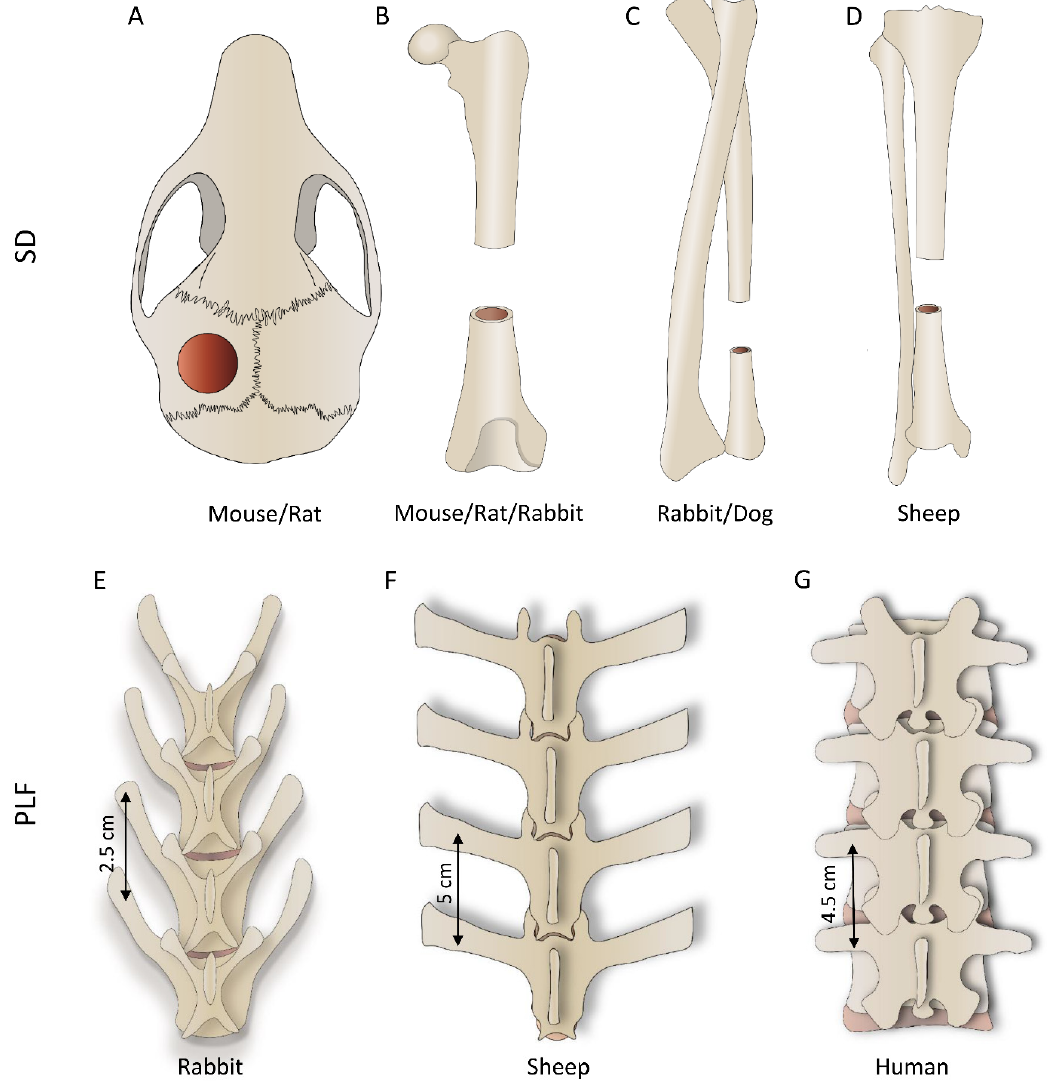
Figure 3. First row: segmental defect (SD) models performed on various bones depending on the species; ( A ) calvarial, ( B ) femoral, ( C ) ulnar (or radial), and ( D ) tibial defect. Second row: posterolateral lumbar fusion (PLF) is conducted between adjacent transverse processes; the figure shows differences in the anatomy of rabbit ( E ), sheep ( F ), and human ( G ) lumbar